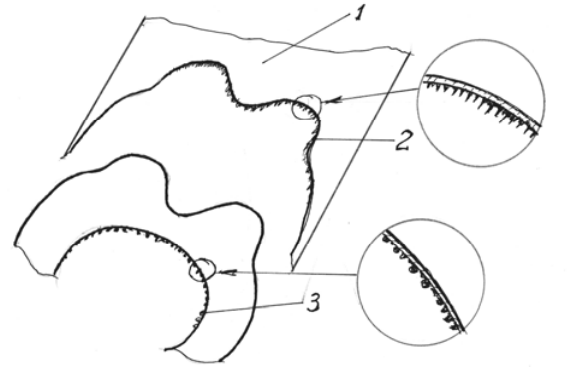
Fig 3. Scheme of erosion products deposited on the lower edge of the cut. 1- stainless steel band, 2- “icicle” form erosion products with prevailing super paramagnetic and magnetic FeCr phase in their composition, 3- “bubble” form erosion products with prevailing magnetic Fe 3 O 4 and (FeCr) 3 O 4 phase Samples collected from the chamber-catcher bottom at a distance of 120 mm from the cut zone are